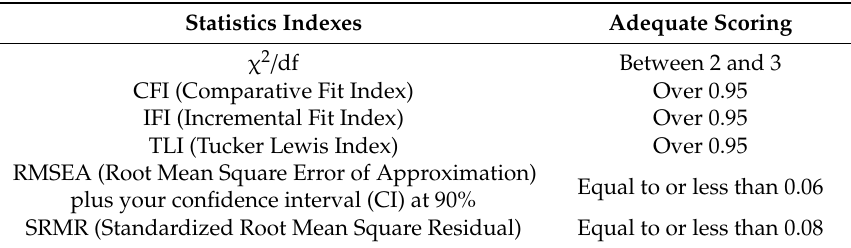
Table 2. Adjustment indexes.